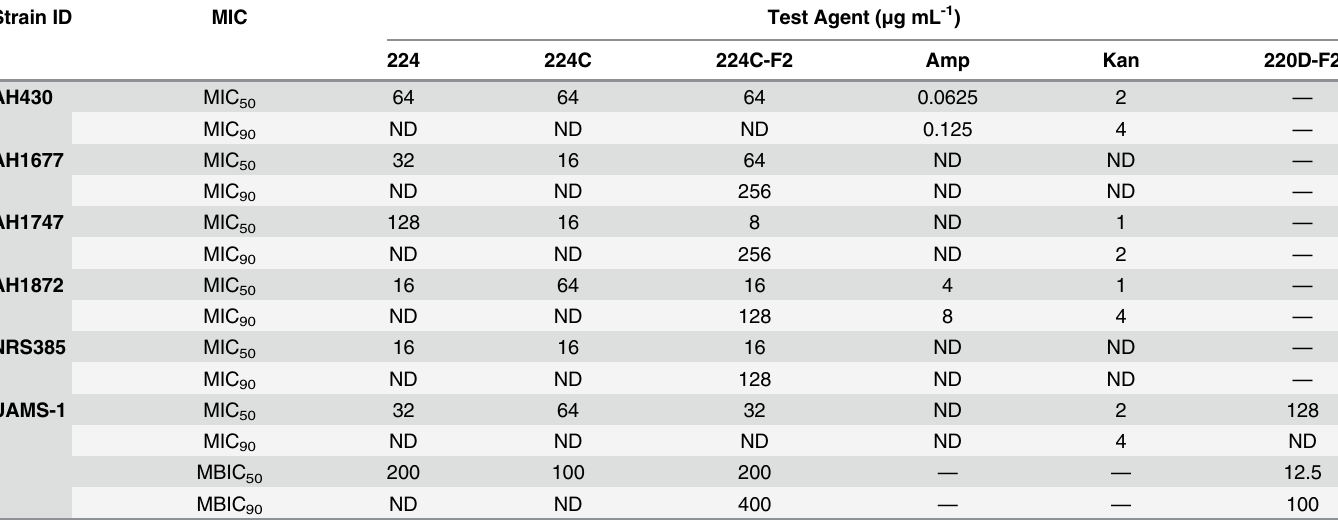
Table 2. Growth and biofilm inhibition studies. Minimum inhibitory concentrations (MIC) were determined for extracts 224, 224C, 224C-F2 and control antibiotics (Ampicillin and Kanamycin) against Staphylococcus aureus strains. Minimum biofilm inhibiting concentration (MBIC) determination is also pre- sented, and compared to control extract 220D-F2. All MIC and MBIC values are represented in μ g mL -1 . Strain